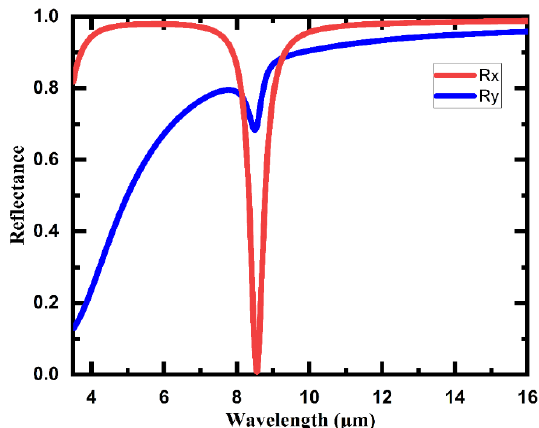
Figure 4. Simulated reflection spectra of the 3D meta-atom array with a smaller claw gap. Rx and Ry are the reflection spectra of the array under normally incident IR light with the polarization direction parallel to X-axis and Y-axis, respectively.